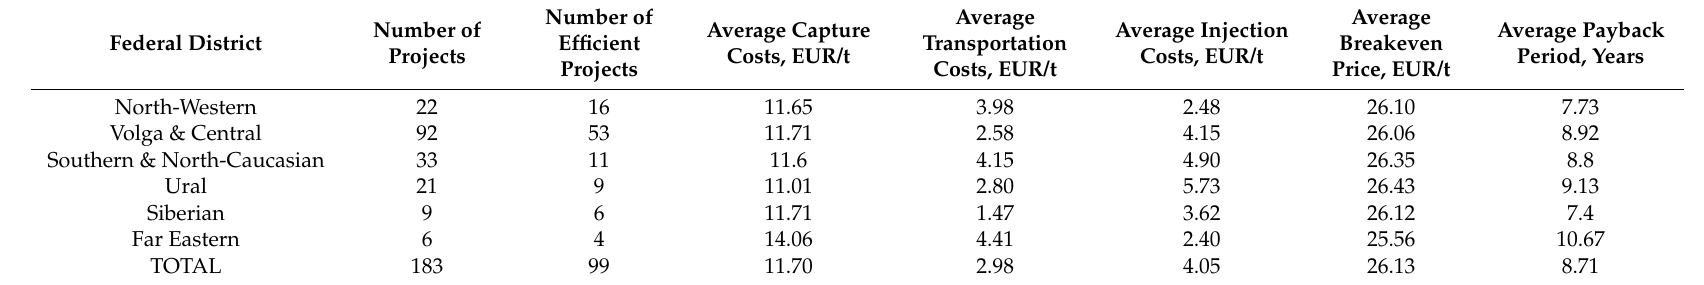
Table 5. Economic analysis of CO 2 -EOR projects in